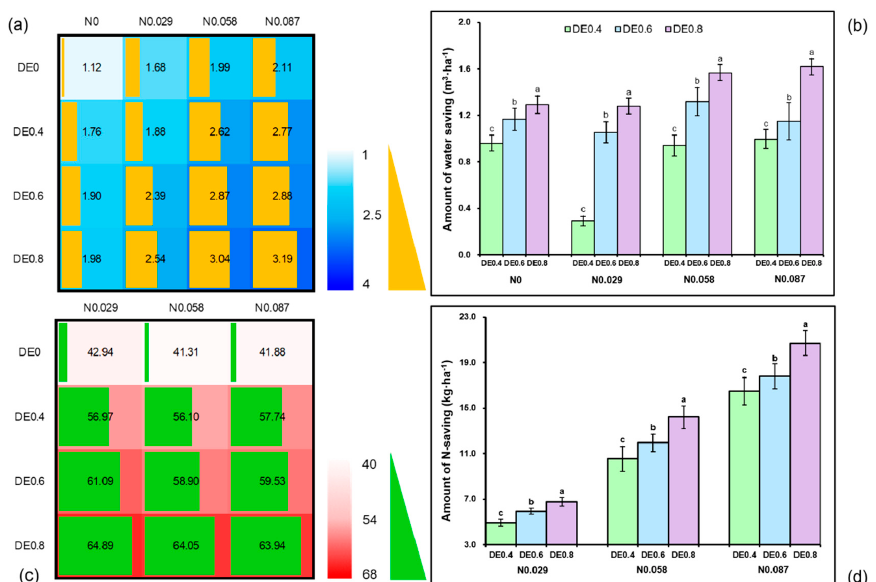
Figure 4. Effects of DewEco (DE) and N application on water and N use efficiency. ( a ) Changes in water use efficiency (WUE) after DewEco and N application. Darker blue shading represents better WUE, and the size of the yellow area (from 1 to 4) represents the value of WUE. ( b ) The amount of water saved when DE and N were added to sandy soils. ( c ) Changes in N use efficiency (NUE), darker red shading represents better NUE, and the size of the green area (from 40 to 68) represents the value of NUE. ( d ) The amount of N saved when DE and N were added to sandy soils. Values with different letters are significantly different at p ≤ 0.05.